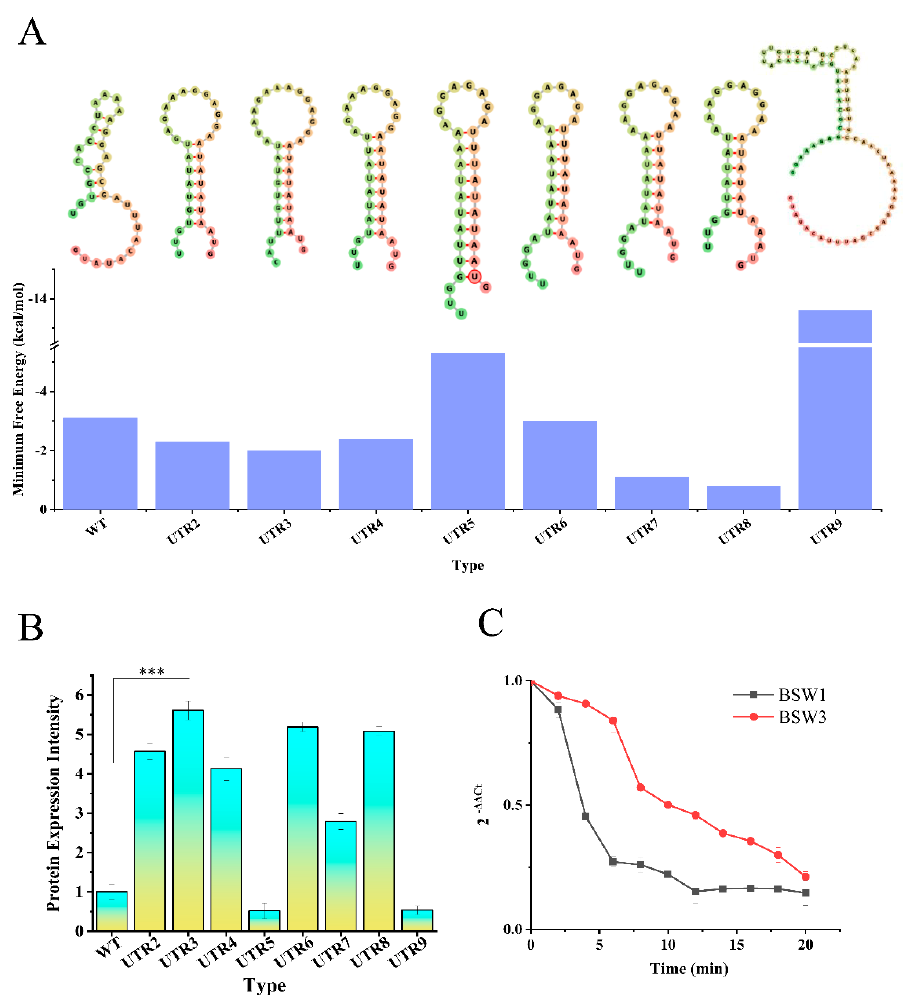
Figure 5. Protein overexpression with a portable 5 ′ -UTR. ( A ) MFE plain structures of the 5 ′ -UTR and its corresponding minimum free energy values are presented in the bar chart below. ( B ) Protein expression levels from constructs with different 5’-UTRs located before the ATG start codon. *** p < 0.005. ( C ) Intracellular LreuglsA mRNA levels in BSW1 and BSW3 at different times after the addition of rifampicin. Each experimental data point is the average of three independent experiments, and the error bars indicate standard deviations.